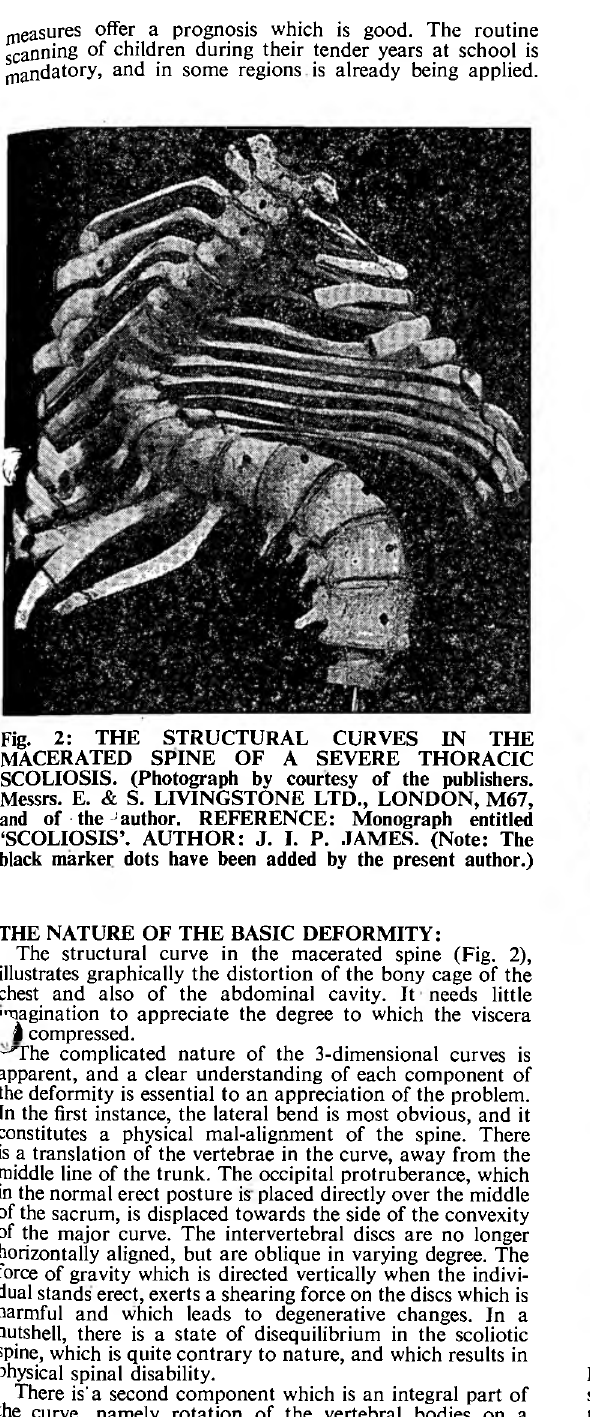
Fig. 3: Diagrammatic representation of a bird’s eye - view showing a silhouette of the skull of a patient with severe thoracic scoliosis, convex to the right side, (a) Vertebral body rotated towards the side of the convexity of the curve, (b) The rib hump, (c) The obliterated pleuralcavity on right, (d) The aorta, (e) The unicameral pleural cavity which contains left and right lungs and mediastinal contents including the heart. . (f) The